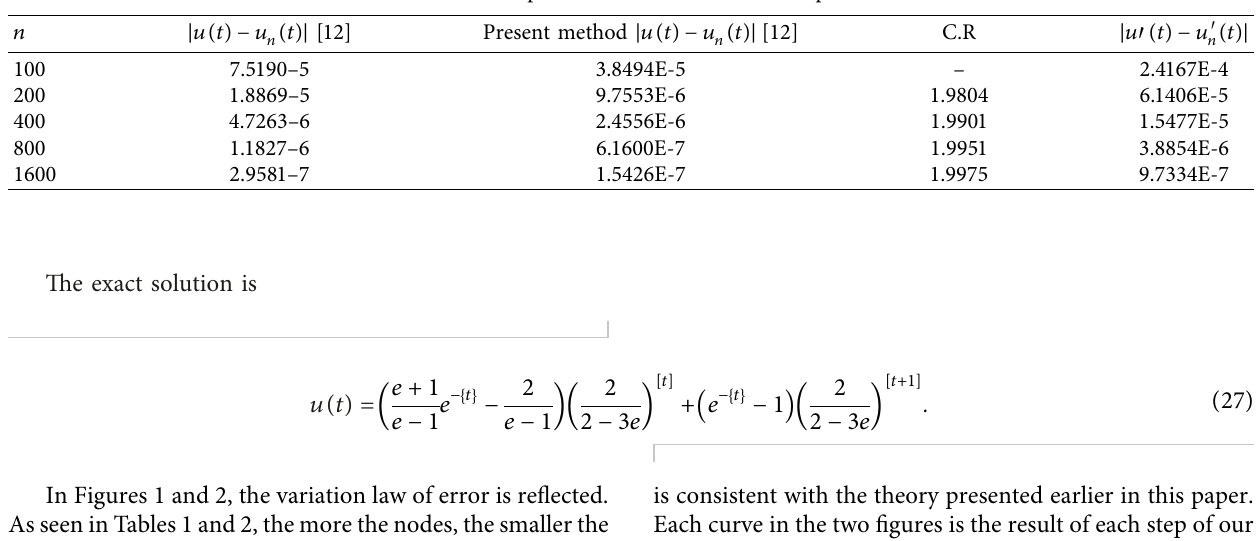
Table 1: Comparisons of the results of Example